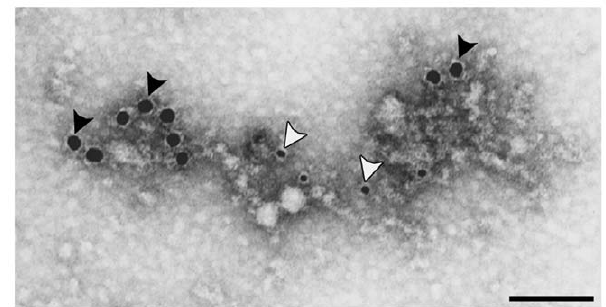
Figure 6. Collagen VI suprastructure analysis. A, Collagen VI suprastructures were isolated from human articular cartilage extracts using superparamagnetic immunobeads coupled to collagen VI antibodies. The isolated suprastructures were then doubly immuno- labeled with sheep anti-WARP antiserum (18-nm gold particles; black arrowheads) and rabbit anti-collagen VI antibody (small gold particles; white arrowheads). WARP is present in collagen VI suprastructures. Scale bar is 100 nm.